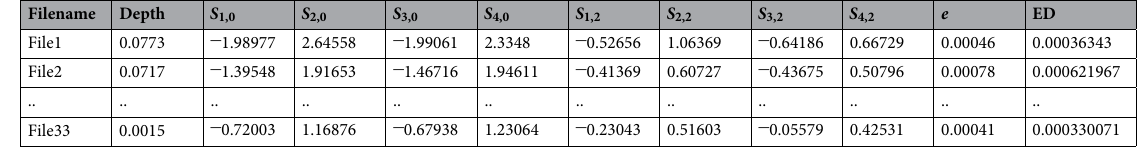
Table 8. Statistical parameters of turbulence obtained via P-SAT (Continued...).